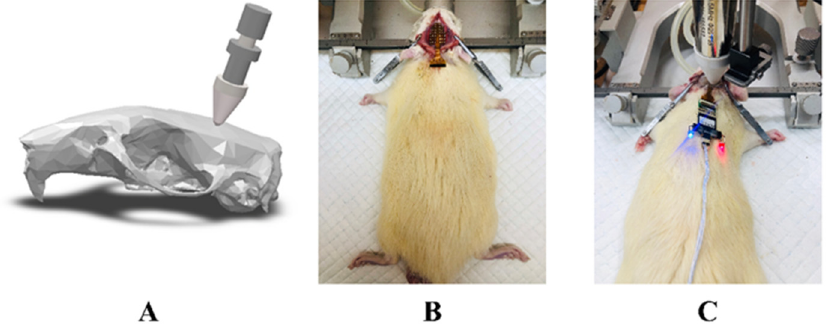
Figure 2. ( A ) Schematic diagram of ultrasound transducer and skull model. ( B ) Implantation with an EEG electrode. ( C ) A rat undergoing sonication.